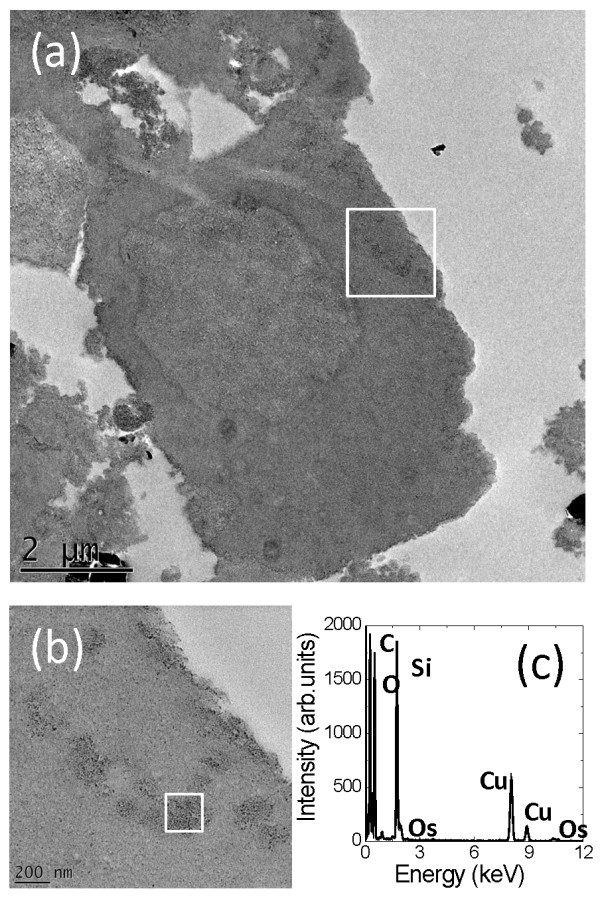
(a) TEM image of A549 cellular uptake of silica NPs after incubation with 100 μg/ml for 30 mins at 4°C. (b) Higher magnification image of the area indicated by the box in (a). (c) EDX spectrum from the silica NP containing region of the A549 cell indicated by the box in (b).